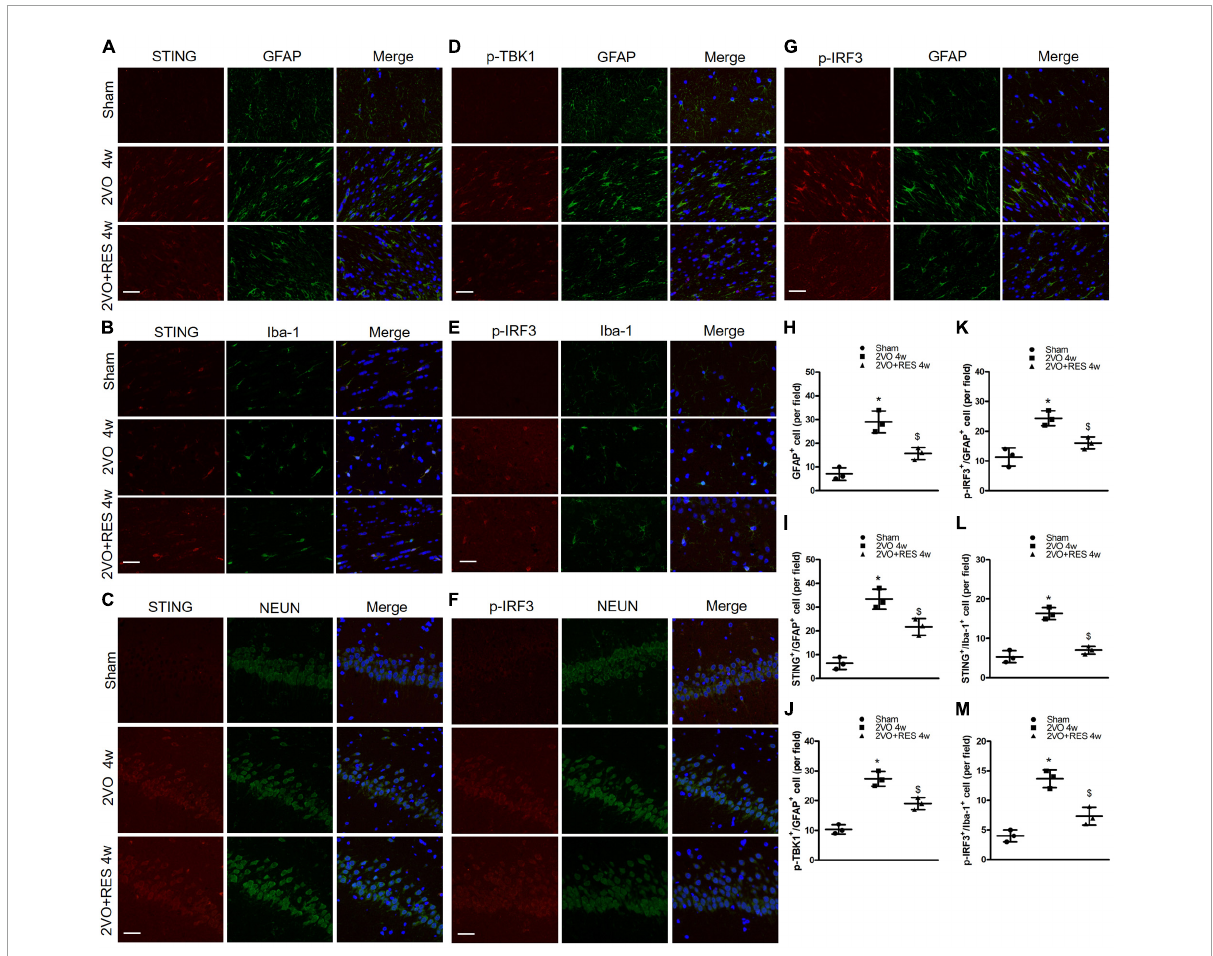
FIGURE5 (A,D,G) Representative images of astrocytes (GFAP-positive cells, green) and stimulator of interferon genes (STING) (red), p-TANK-binding kinase 1 (p-TBK1; red), p-interferon regulatory factor 3 (p-IRF3; red) immunofluorescence double-labeling in white matter at 4 weeks after bilateral common carotid artery occlusion (2VO). (C,F) shows immunofluorescence of STING (red) and p-IRF3(red) expression were colocalized with neurons (NEUN-positive cells, green) in the hippocampus. (B,E) Representative immunofluorescent images of microglia (Iba-1-positive cells, green) and STING (red), p-IRF3(red) immunofluorescence double-labeling in white matter. ( × 400, Blue, DAPI, Scale bar, 20 µ m, n = 3 per group) (H) Quantitative analysis of the number of GFAP + cells. (I–K) Quantitation of the number of STING + /GFAP + cells, p-TBK1 + /GFAP + cells, and p-IRF3 + /GFAP + cells in different groups. (L,M) Quantitation of the number of STING + /Iba-1 + cells, p-IRF3 + /Iba-1 + cells. * p < 0.05 vs. Sham; $ p < 0.05, 2VO + RES 4w group vs. 2VO 4w group. Data are presented as mean ±